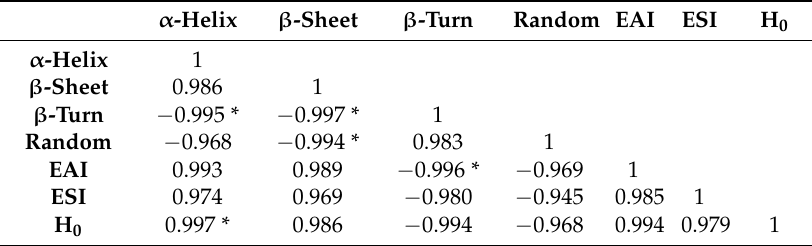
Table 3. Correlation analysis between secondary structure and other